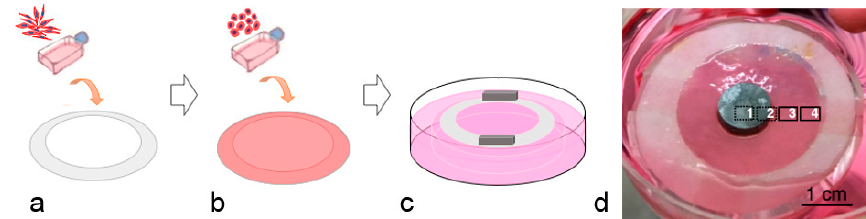
Figure 1. The ureteral wall (UW) model preparation: ( a ) production of stroma, 28 days culture, ( b ) production of tissue equivalent, 7 days culture in submerged condition, ( c ) displacement of tissue equivalent into petri dish, 21 days culture, ( d ) macroscopic view of the UW model with metal in place for direct toxicity test, the areas marked 1–4 are the area used for histological analysis.